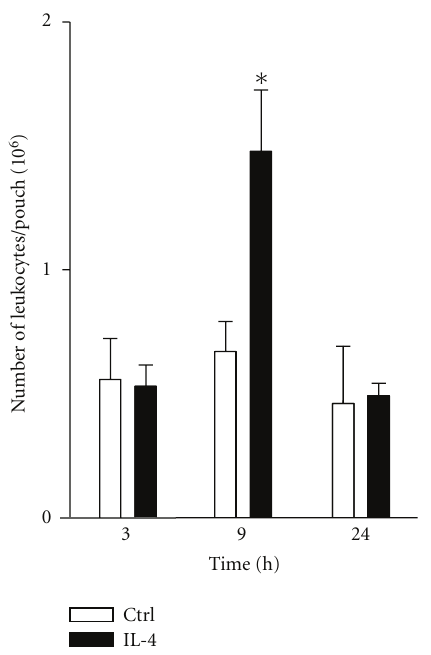
Figure 1: IL-4 induces inflammation in vivo . Murine air pouches were raised before injection of bu ff er (Ctrl) or 250 ng/ml IL-4 and exudates were harvested at the indicated periods of time and the number of leukocytes was calculated. Results are means ± SEM ( n ≥ 6). ∗ P < . 05 versus